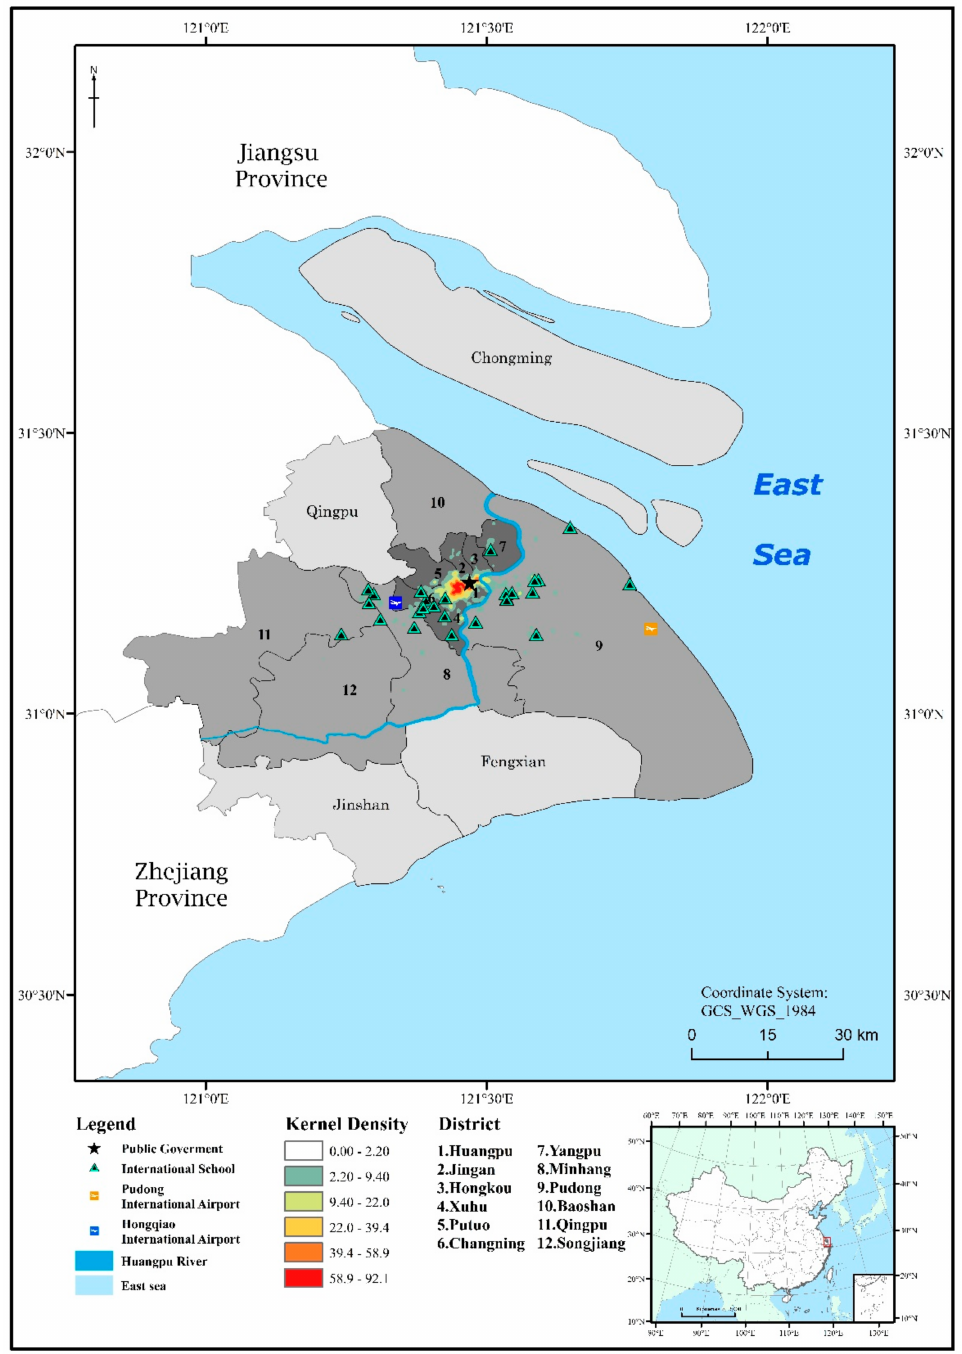
Figure 6. The geographical layout of expatriates’ cultural